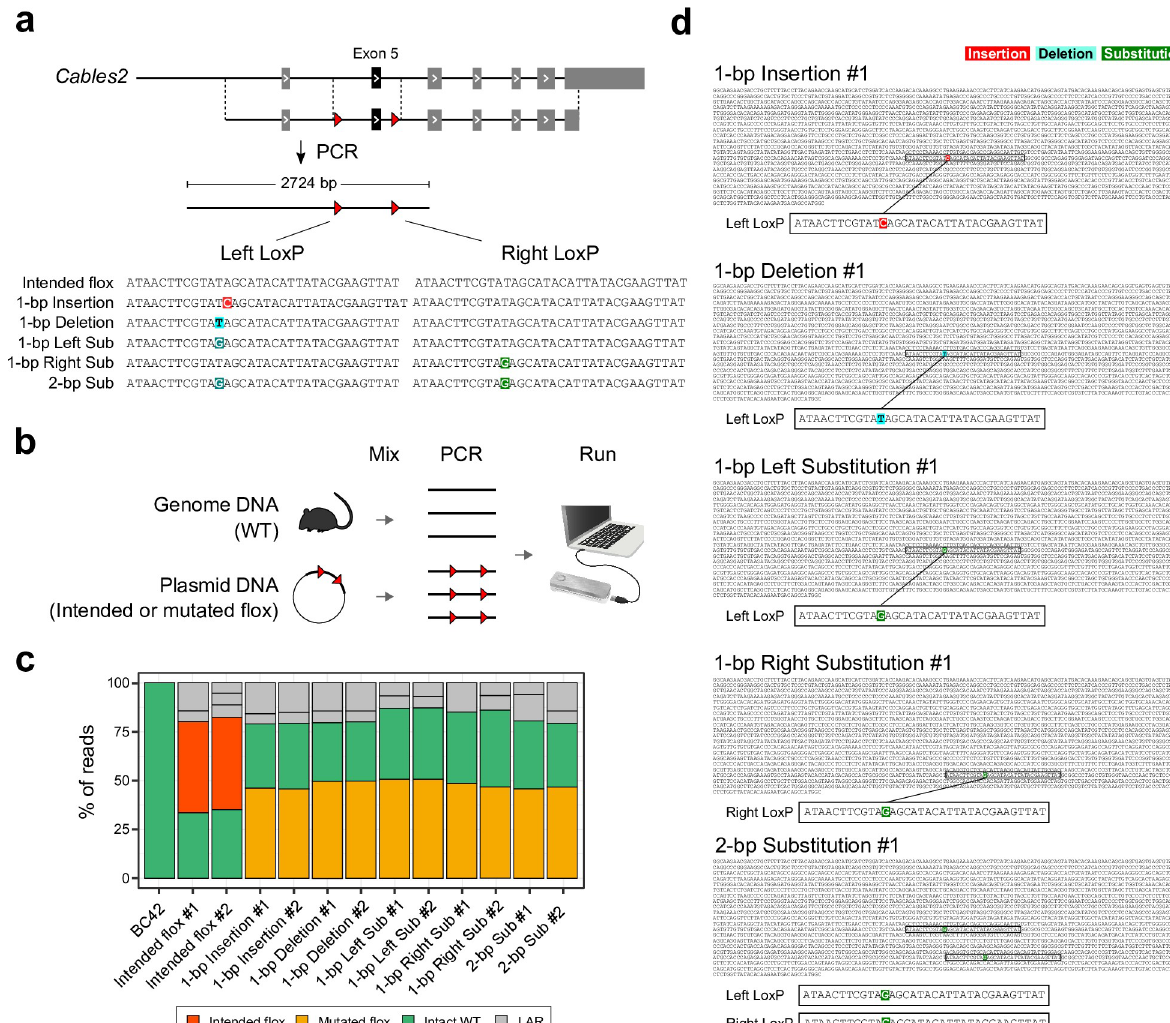
Fig 5. Precise SNV detection in flox KI allele. (a) Genome editing design. The red arrowheads represent LoxPs. The colours on the nucleotides represent the types of mutations, including insertion (red), deletion (sky blue), and substitution (green). (b) Experimental design. Illustrations were modified from the Togo picture gallery, licenced under CC-BY 4.0 Togo picture gallery by the DBCLS, Japan. (c) DAJIN’s report of the allele percentage. The barcode numbers on the x-axis represent sample IDs. Barcode42 is a WT control. The y-axis represents the percentage of DAJIN- reported alleles. The colours of the bar represent DAJIN-reported allele types. The compartments partitioned off by horizontal lines in a bar represent the DAJIN-reported alleles. (d) DAJIN’s consensus sequences of a floxed allele in each sample. The colours on the nucleotides represent mutation types, including insertion (red), deletion (sky blue), and substitution (green). The boxed sequences in the consensus sequences are LoxP sites. See S5 Data for raw data from https://osf.io/w7ade/. DAJIN, Determine Allele mutations and Judge Intended genotype by Nanopore sequencer; DBCLS, Database Center for Life Science; KI, knock-in; LAR, large rearrangement; SNV, single-nucleotide variant; Sub, substitution; WT, wild